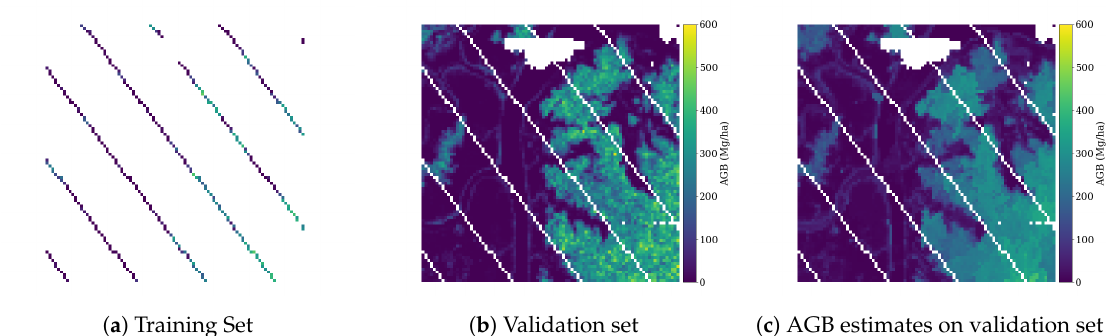
Figure 6. The train/validation framework to simulate Global Ecosystem Dynamics Investigation (GEDI) spatial sampling from the lidar-derived AGB reference